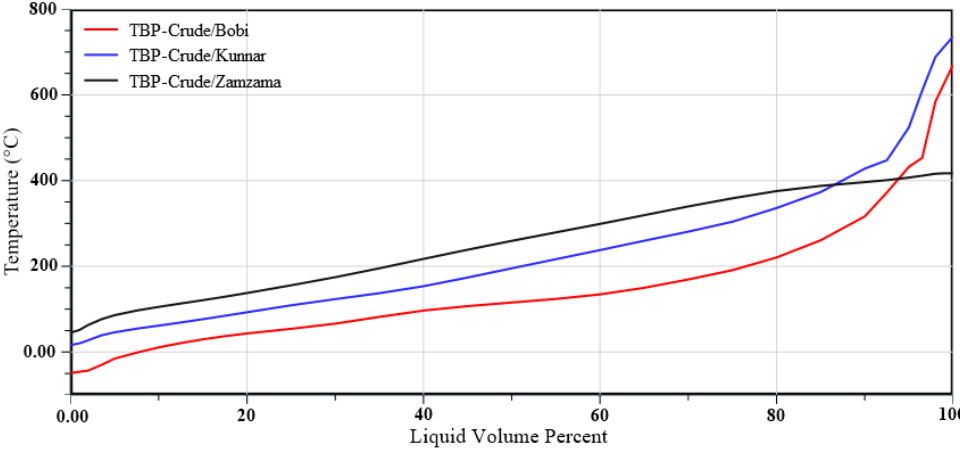
Figure 3. TBP Curves for the three Pakistani Crude Oils generated through Aspen HYSYS. Table 1. Specifications of Pakistani Crudes: Bobi, Kunnar and Hot crude from the furnace and the pre-flash vapor from the pre-flash column were passed through the mixer and then introduced at the tray 28 of the column. Three side-strippers, each of